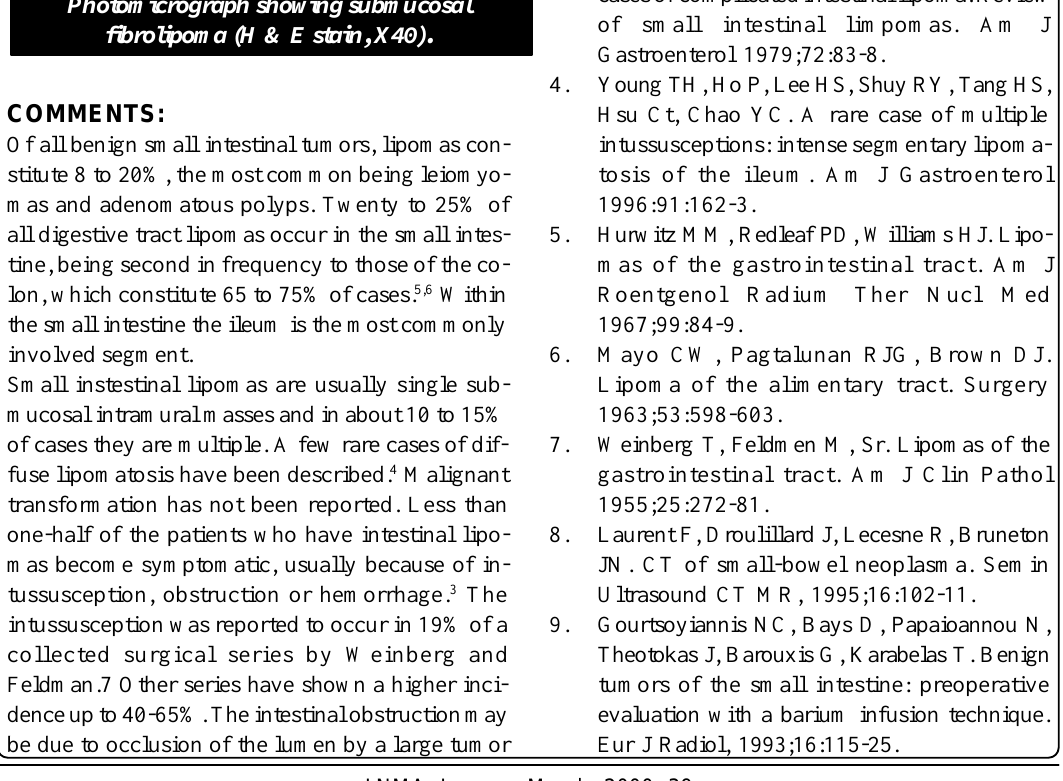
Photomicrograph showing submucosal fibrolipoma (H & E stain,